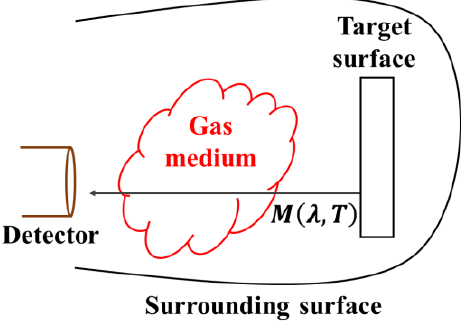
Figure 6. A basic schematic diagram of radiation thermometry. Total Radiation Thermometry